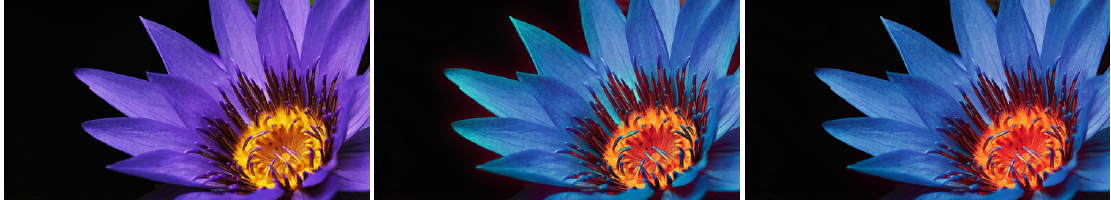
Figure 5. Halo artefacts in the isotropic daltonisation algorithm for a BY α = 1 observer. ( Left to right ): original image, isotropic daltonisation, and anisotropic daltonisation.